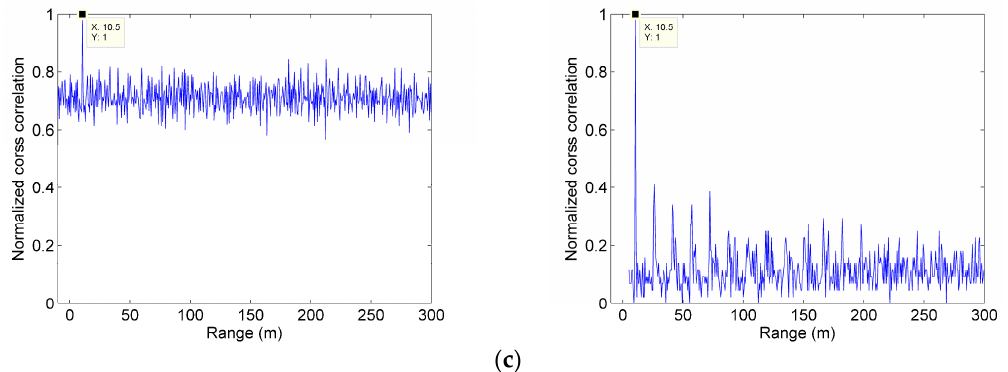
Figure 9. Cross-correlation range images with three different echo photon numbers for the traditional PSPCR Lidar and the modulation-encoded PSPCR Lidar. The first column is the traditional PSPCR Lidar, and the second column is the modulation-encoded PSPCR Lidar. The mean echo photon number per ‘1’ bit in ( a ), ( b ) and ( c ) is 1, 3, and 5, respectively.